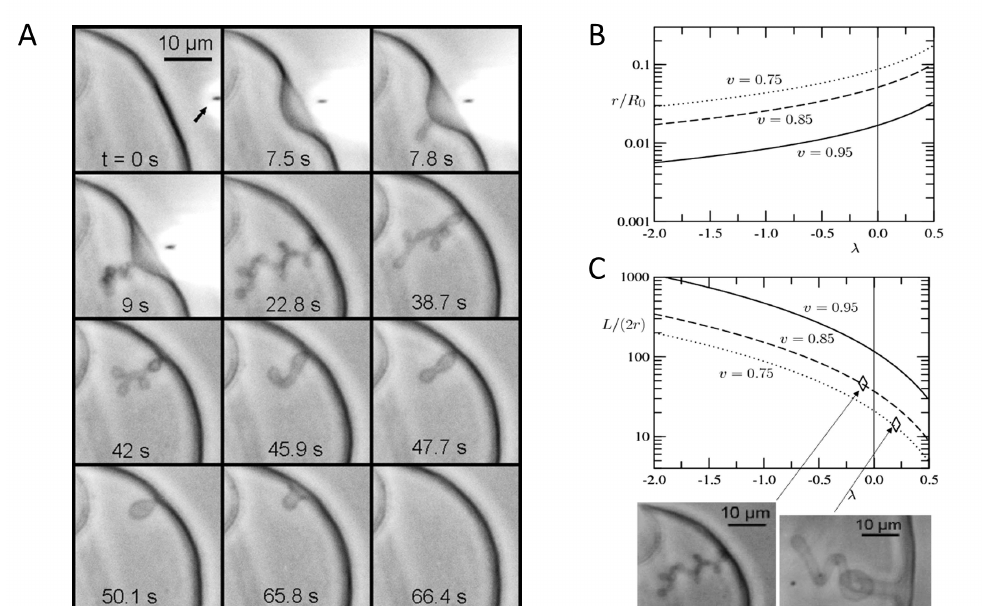
Figure 6. Cristae-like membrane invaginations. ( A ) Modulation of local pH gradient at membrane level of a cardiolipin containing vesicle induces dynamic cristae-like membrane invaginations. GUV is made of PC/PE/CL 60:30:10 mol/mol in buffer at pH 8. The local delivery of HCl (100 mM pH 1.6), which lowers the local pH, is carried out by a micropipette (its position is pointed by the arrow in frame t = 0 s).The induced membrane invagination (frame 22.8 s) is completely reversible (frames 38.7–66.4) as far as the acid delivery is stopped. Geometrical features of the tubular invagination calculated from the model as a function of the area reduction factor λ that is controlled by the acid delivery (the lower λ , the stronger acid effect): ( B ) Radius of the tube normalized by the radius of the initial vesicle. ( C ) Aspect ratio of the tube. Both are given for three experimentally relevant values of the reduced volume v of the initial vesicle. Two experimental illustrations are given for ν = 0.85 and 0.75 and L/(2r) ratios ∼ 40 and 14, respectively. Reproduced with permission from Khalifat et al. [86], Biophys. J.; published by Elsevier, 2008.